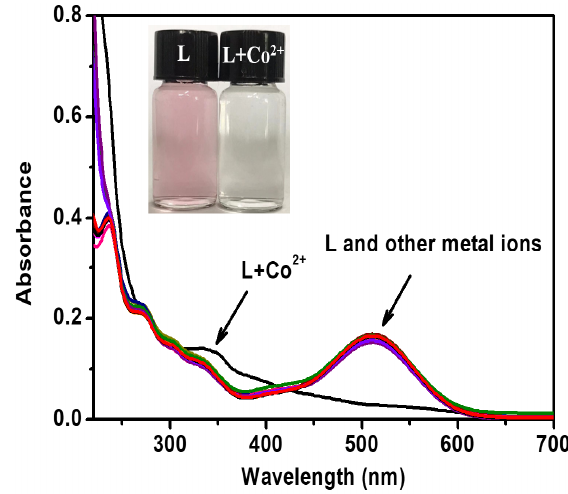
Figure 1. UV-Vis absorption spectra of L (1 × 10 − 5 mol L -1 ) and upon the addition of salts (five equivalents) of Na + , K + , Ag + , Cu + , Mg 2+ , Zn 2+ , Ca 2+ , Sn 2+ , Cu 2+ , Ni 2+ , Mn 2+ , Pb 2+ , Cd 2+ , Ba 2+ , Hg 2+ , Fe 2+ , Co 2+ , Fe 3+ , Al 3+ and Cr 3+ in a CH 3 CN/HEPES (4/1, v / v , pH = 7.4) solution. Inset: Visual colorimetric response of L with Co 2+ .